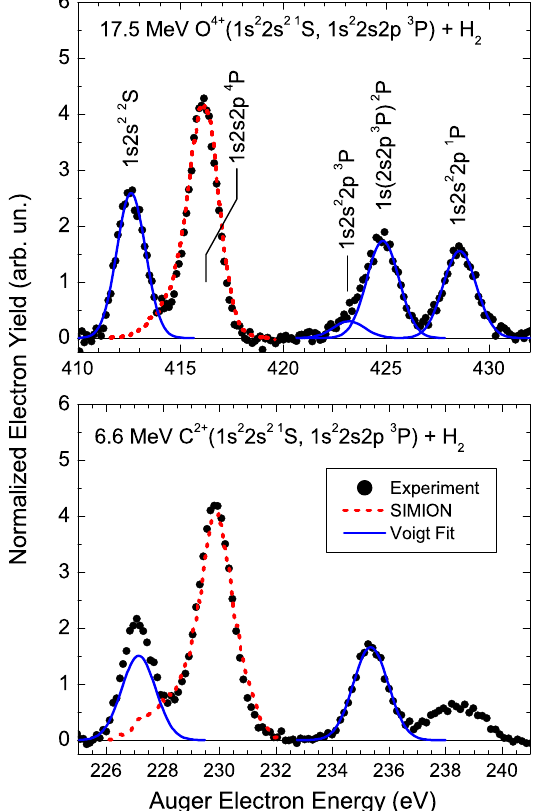
Figure 4. Auger KLL spectra obtained in collisions of 17.5 MeV O 4 + and 6.6 MeV C 2 + with H 2 targets (from Ref. [89]). SIMION simulations of the 4 P line distributions are shown by the short dash line in excellent agreement with the measurements. The solid lines correspond to Voigt profile least square fits of the Auger